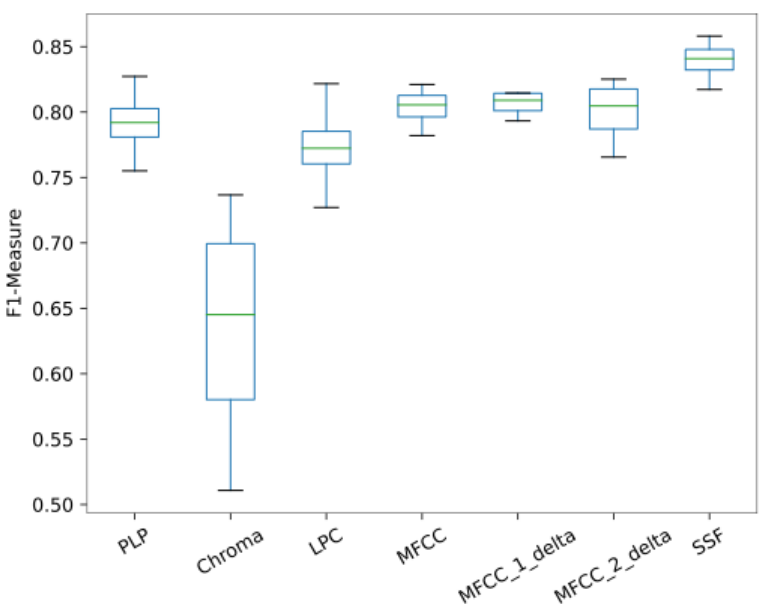
Figure 5. Performance of each audio feature in the Electrobyte dataset individually.